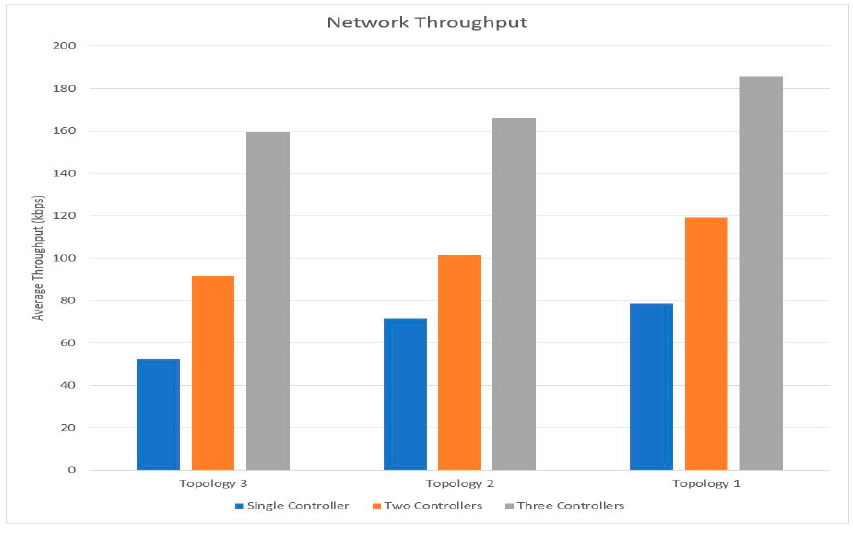
Figure 8. Network